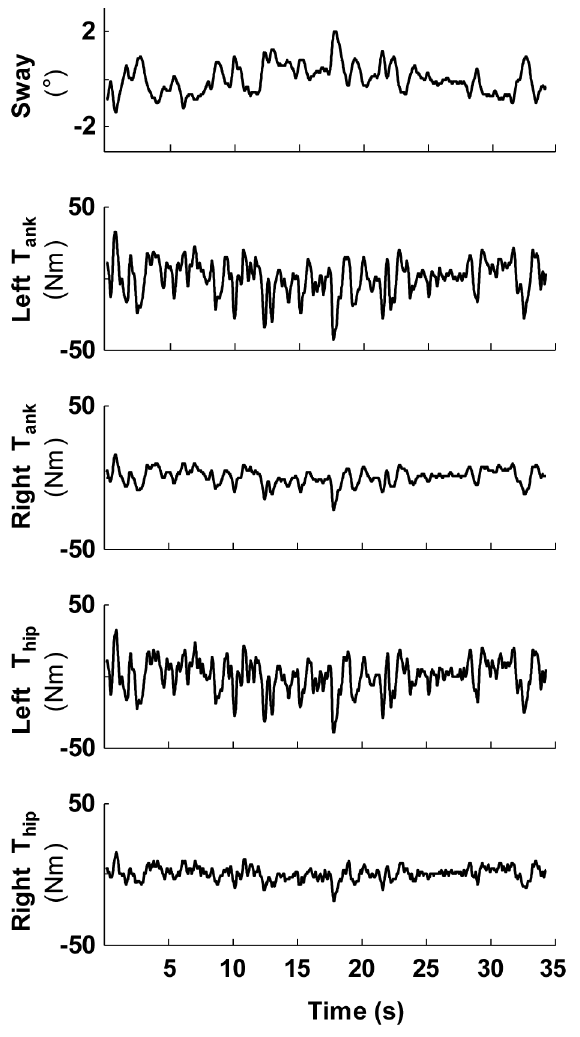
Figure 3. Timeseries of a representative Parkinson patient of one perturbation cycle. The upper two panels represent the platform and pusher perturbations. The lower four panels show the participants’ response. Note that there are clear asymmetries in the joint torque responses. right ankle contributed by 87 percent to upright stance. However, there were also PD patients who controlled their balance symmetrically, for example patient two. Although there were balance-control asymmetries at both joints, Figure 4 shows that these were less pronounced at the hip joint. Furthermore, a weight- bearing asymmetry was not always accompanied by a balance-control asymmetry (e.g., pt 5) or vice versa (e.g., pt 13). Also, the amount of weight-bearing asymmetry was not always the same as the balance-control asymmetry. For example, in patients six and 11, the weight-bearing asymmetry was smaller than the balance-control asymmetry of the ankle joint. Most patients used their right leg more than their left leg to maintain upright balance. Except for patient two, all patients showed balance asymmetries, either in unevenly distributed weight or in different balance- control contributions of the left and right leg at the ankle or hip joint.